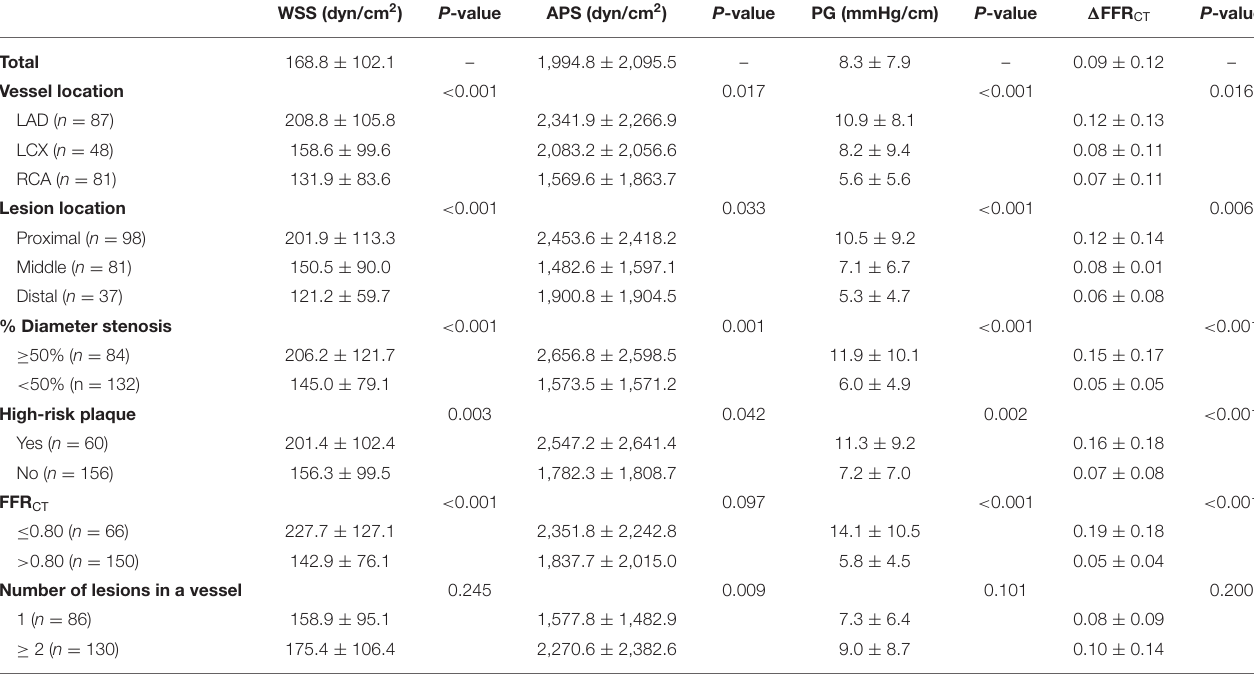
TABLE 1 | Local hemodynamics according to lesion